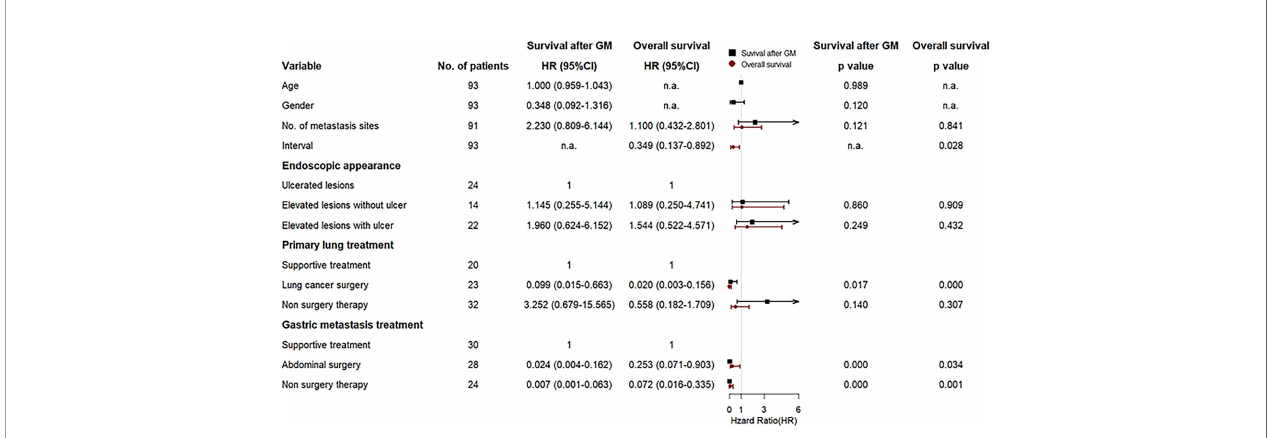
FIGURE 7 | Forest plot for the multivariate Cox regression analyses of variables that may affect survival after gastric metastasis and overall survival of the gastric metastasis from lung cancer